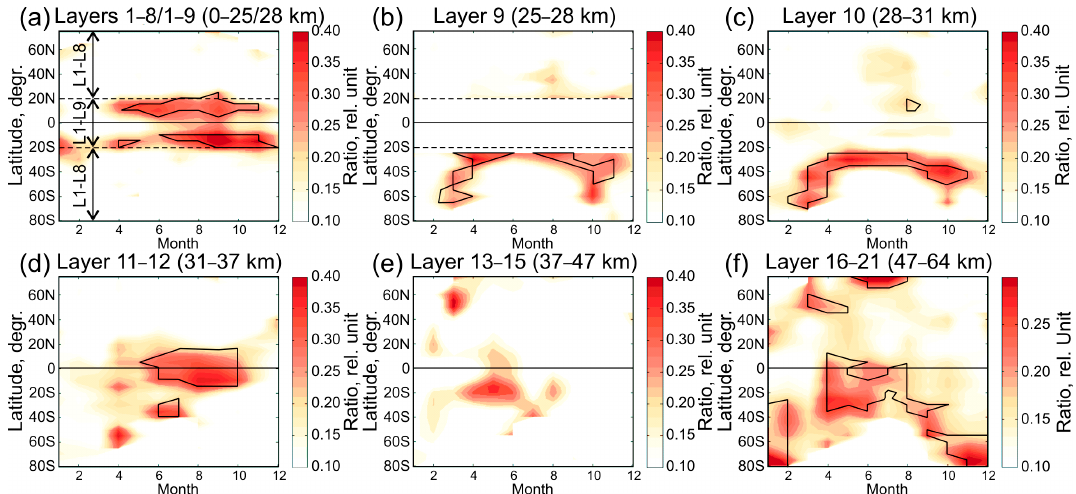
Figure 8. Ratio of the intensity of the wavelet transform with periods of 10–12 years to the intensity of periods of 2–33 years in ( a ) L1–L8 poleward of 20° latitude and L1–L9 equatorward of 20° latitude marked by dashed lines and signed arrows, ( b ) L9 poleward of 20° latitude, ( c ) L10, ( d ) L11–L12, ( e ) L13–L15, and ( f ) L16–L21. Contours show the 95% confidence level. Note the different color scale in Figure 8f due to lower ratios.